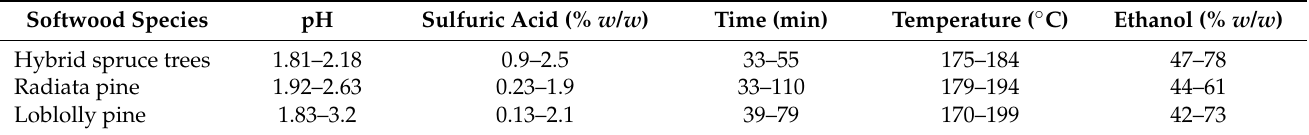
Table 2. Pulping conditions for the three softwood species at a 6:1 liquor-to-wood weight ratio.